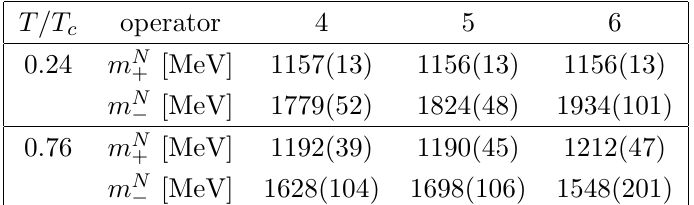
Table 3 . Operator dependence of m N